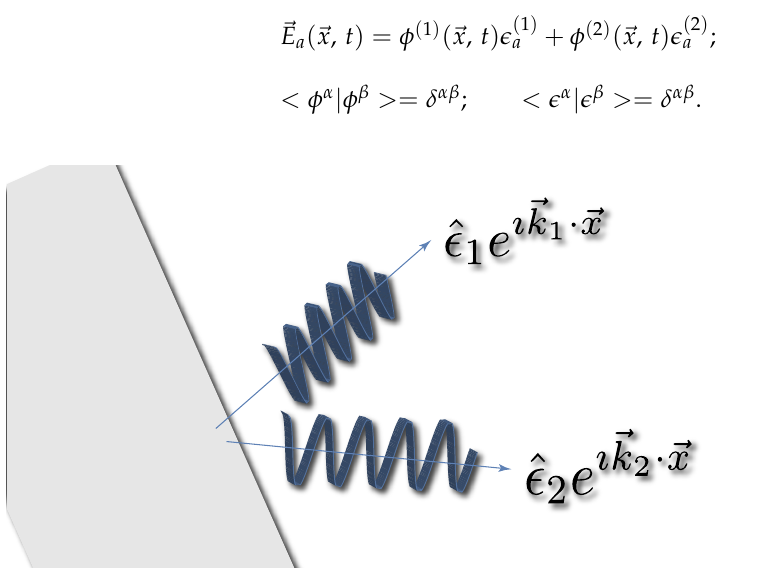
Figure 4. The singular value decomposition explains how there must be strict correlations between product states, as observed with clarity in the 1820s and again with confusion in the 1920s. See Equation (3) for the explainations of the